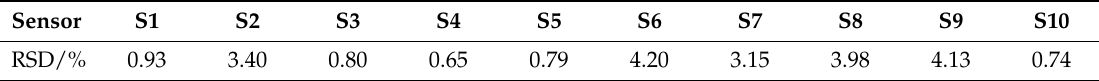
Table 2. The Repeatability of response values of E-nose 10 sensors ( n = 6).